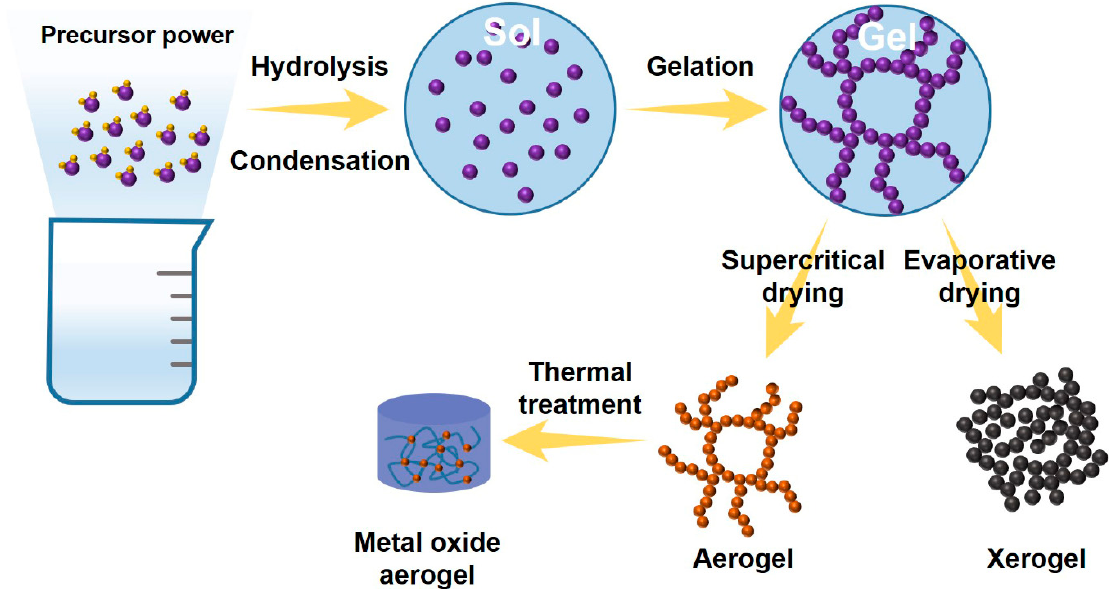
Figure 2. Reaction routes for the production of MO nanostructures by the sol–gel method.